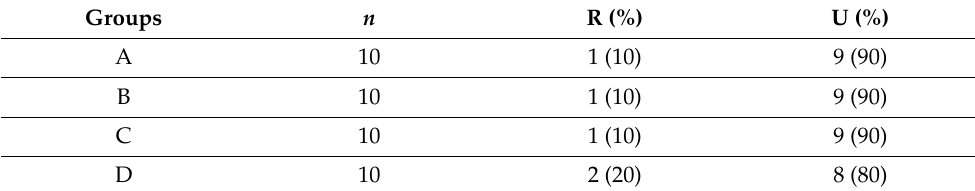
Table 4. Failure